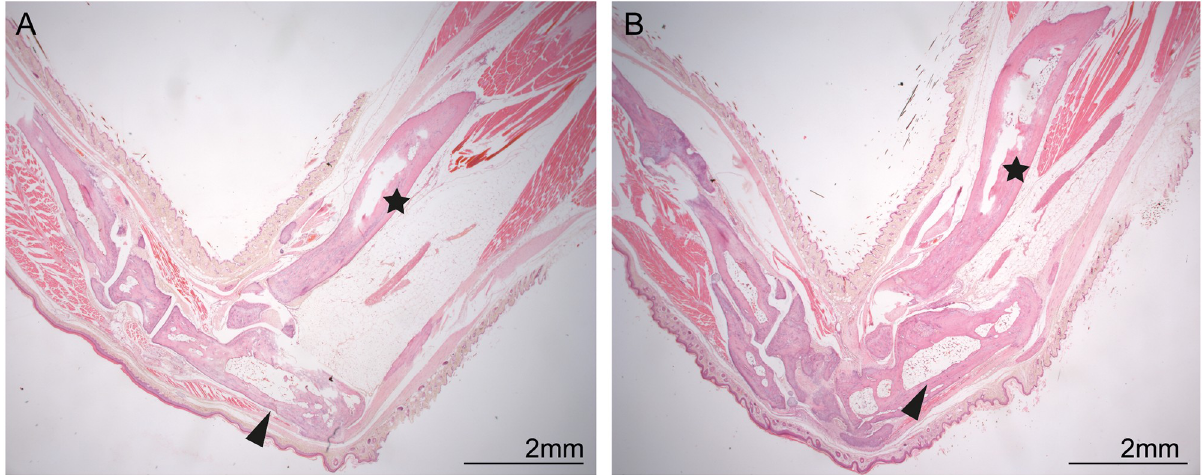
Fig 3. (a) The unaffected tarsus with the calcaneus (black arrow head) forming an approximate 90˚ angle with the tibia (black star), (b) Affected tarsus (black arrow head) with dislocation of the calcaneus caudo-dorsally to form an approximate 15˚ angle with the tibia (black star). The black arrow indicates the direction of movement of the calcaneus. Scale bar =